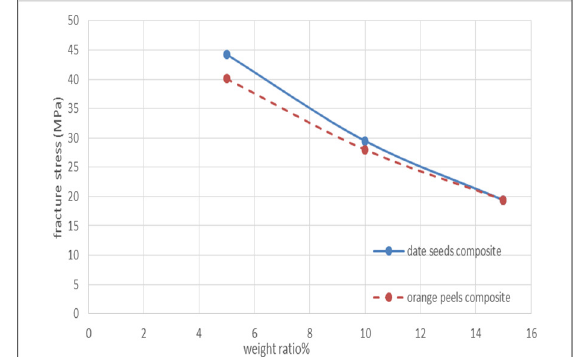
Fig. 7. Effect of weight ratio on yield stress (natural material) Mechanical properties of natural and artificial composite material with mass fraction 5% and particle size 98µm Composite material Young's modulus (MPa) Ultimate stress (MPa) Yield stress (MPa) Pure polyester 1375